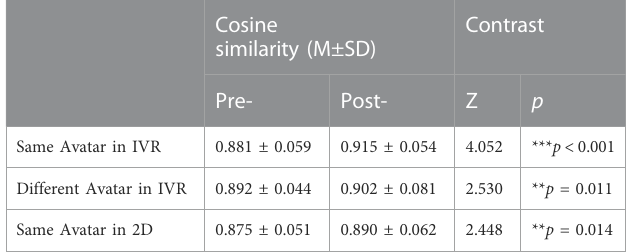
TABLE 1 Cosine Similarities in participant and avatar personalities before and after the role-play (G1: Same Avatar in IVR; G2: Different Avatar in IVR; G3: Same Avatar in